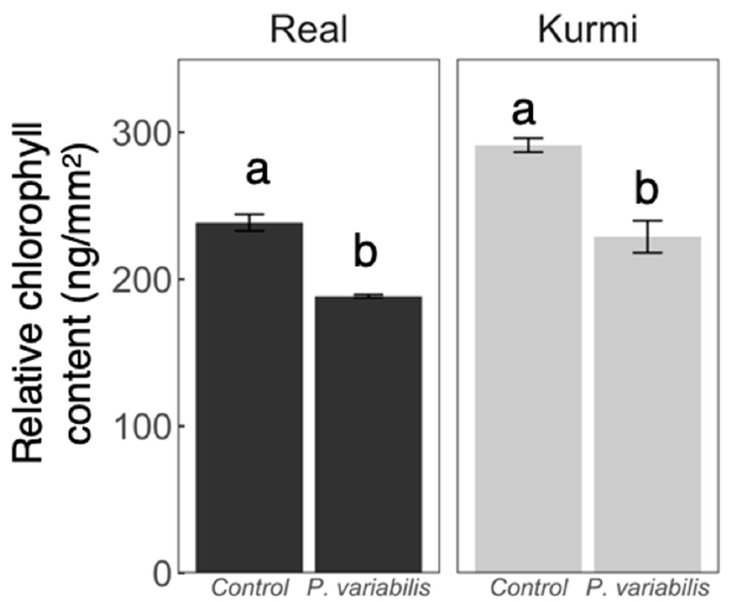
Figure 3. Chlorophyll content in quinoa leaves infected with P. variabilis . The second true leaf of three-week-old quinoa plants at 7 dpi was collected and analyzed. Data show means ± SE per treatment ( n = 4). Different letters mean statistically significant differences according to Student's t test ( p ≤ 0.05).